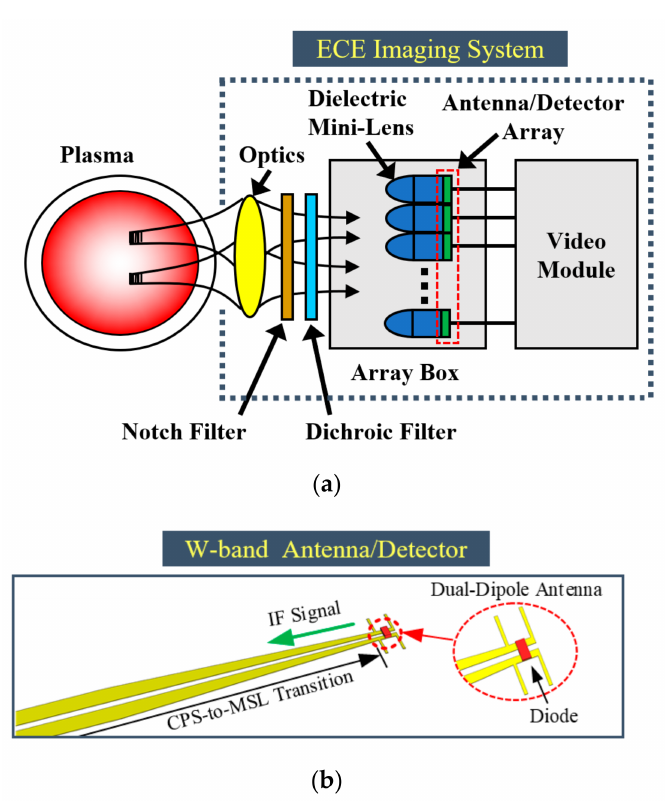
Figure 1. ( a ) Block diagram of the ECE imaging system, ( b ) W-band